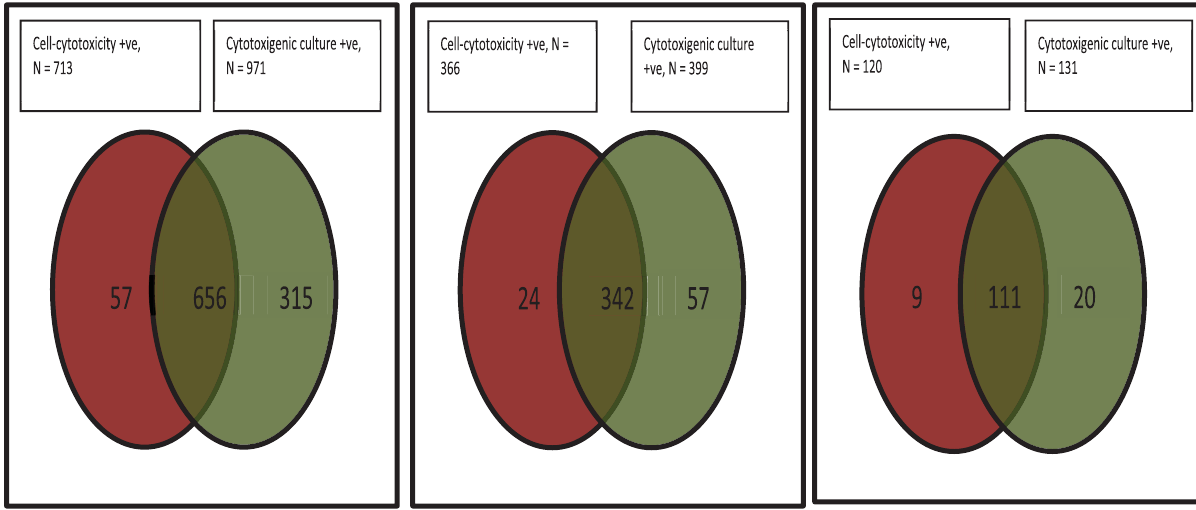
Fig 1. Results of C . difficile reference methods. A) all tgNAAT +ve samples (n = 1281) positive agreement 51.2%; (B) those with only CT < 25 (n = 436) positive agreement 78.4%; (C) those with only CT � 24 (n = 145) positive agreement 76.6%.